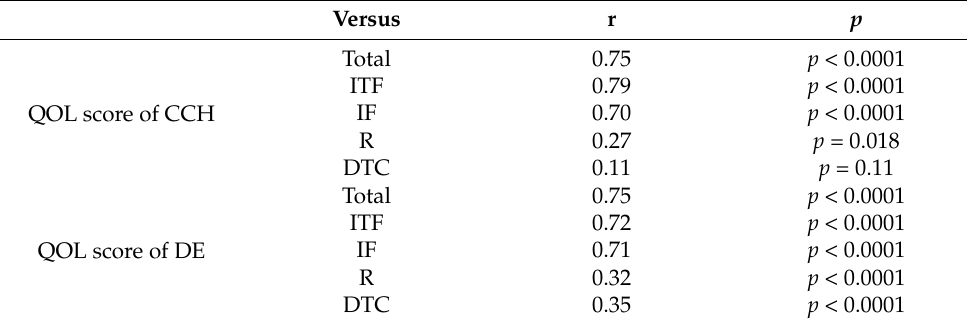
Figure 4. Correlation between VAS score and QOL score in DE. “r” indicates the Spearman correlation coefficient. ITF, instability of tear film; IF, increased friction; R, reflex; DTC, delayed tear clearance. Table 2. Correlation between QOL score and VAS score.